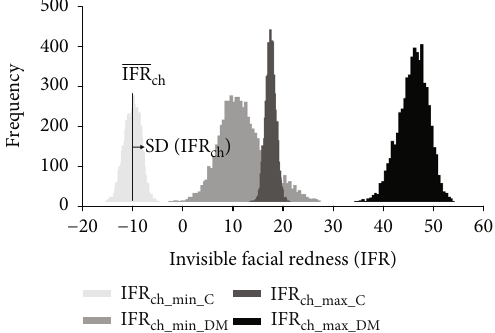
Figure 2: Histograms showing the frequency distributions of the invisible facial redness (IFR) at the two cheeks of one diabetic patient (the least reddish cheek, IFR , and the most ch min DM ) and the two cheeks of one reddish cheek, IFR ch max DM , and the nondiabetic subject (the least reddish cheek, IFR ch min C ). In each distribution, the most reddish cheek, IFR ch max C Þ , measures how spread out the data standard deviation, SD ð IFR ch is, whereas the arithmetic mean ( IFR ) measures where the data ch is